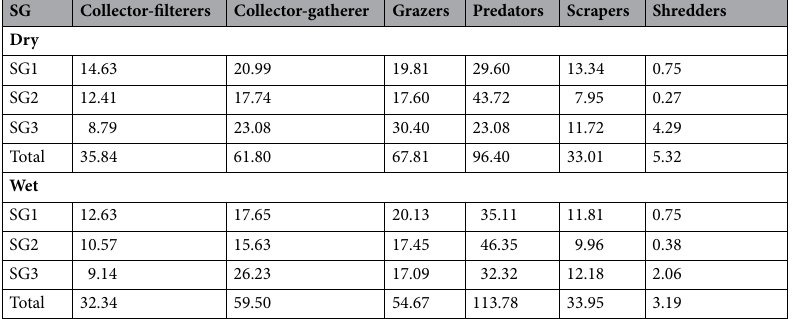
Table 3. Relative abundance (RA) of functional feeding groups (FFGs) of macroinvertebrates across the sampling site categories analysed in this study during the dry and wet seasons (2008–2012). SG1 (Site group 1), SG2 (Site group 2) and SG3 (Site group